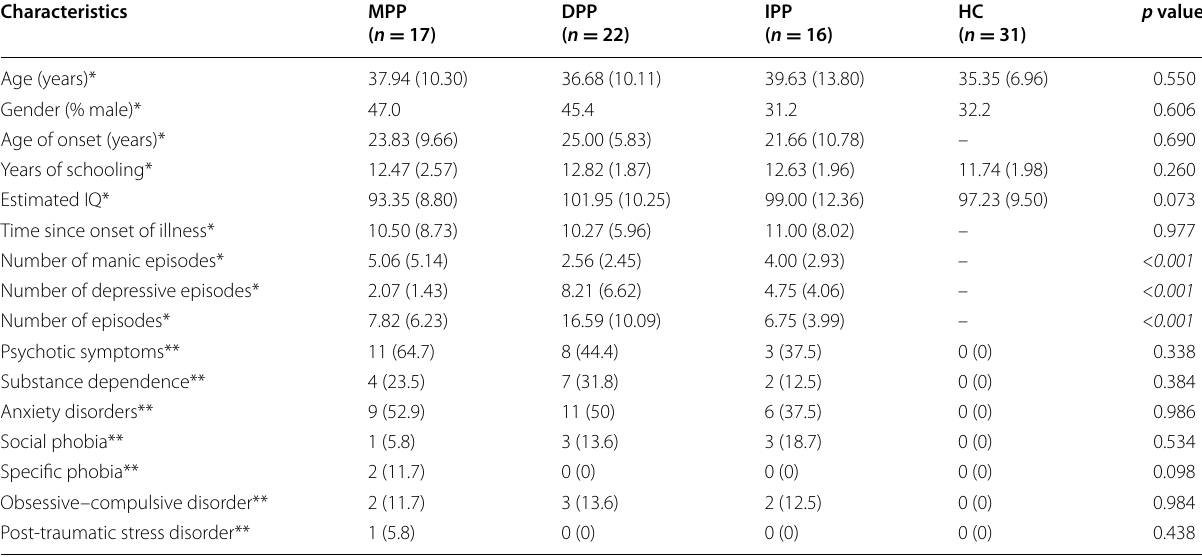
Table 1 Demographic and clinical variables of MPP, DPP, and IPP, and HC